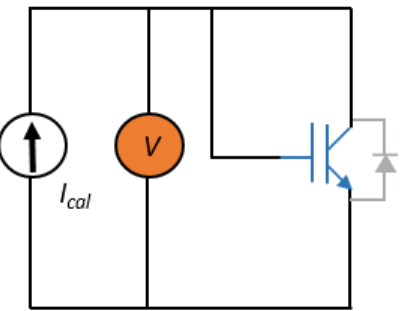
Figure 10. Circuit for the calibration step of the threshold voltage method.